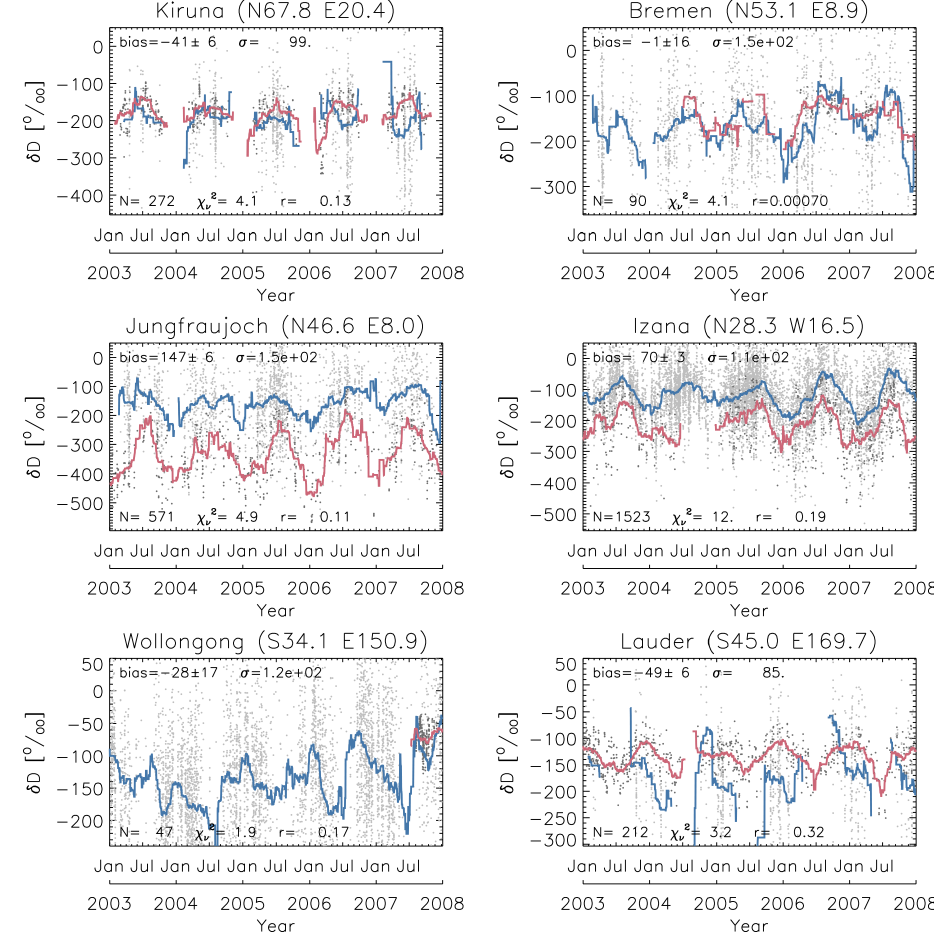
Figure 6. Same as Fig. 5 but now for the MUSICA